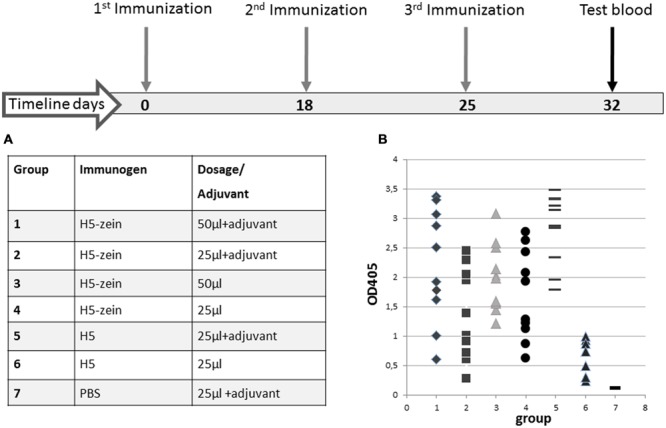
Immunization timeline and IgG responses in the seven treatment groups. (A) All mice were injected with a primary dose of H5-zein (6 μg/ml) or H5 (0.6 mg/ml), both in sterile PBS, with or without Freund’s complete adjuvant. For the second and third injections, the adjuvant was switched to Freund’s incomplete adjuvant. (B) ELISA analysis of the anti-H5 IgG response following the third immunization. A single dot represents the ELISA result from a single serum sample. Each treatment group comprised 10 mice.